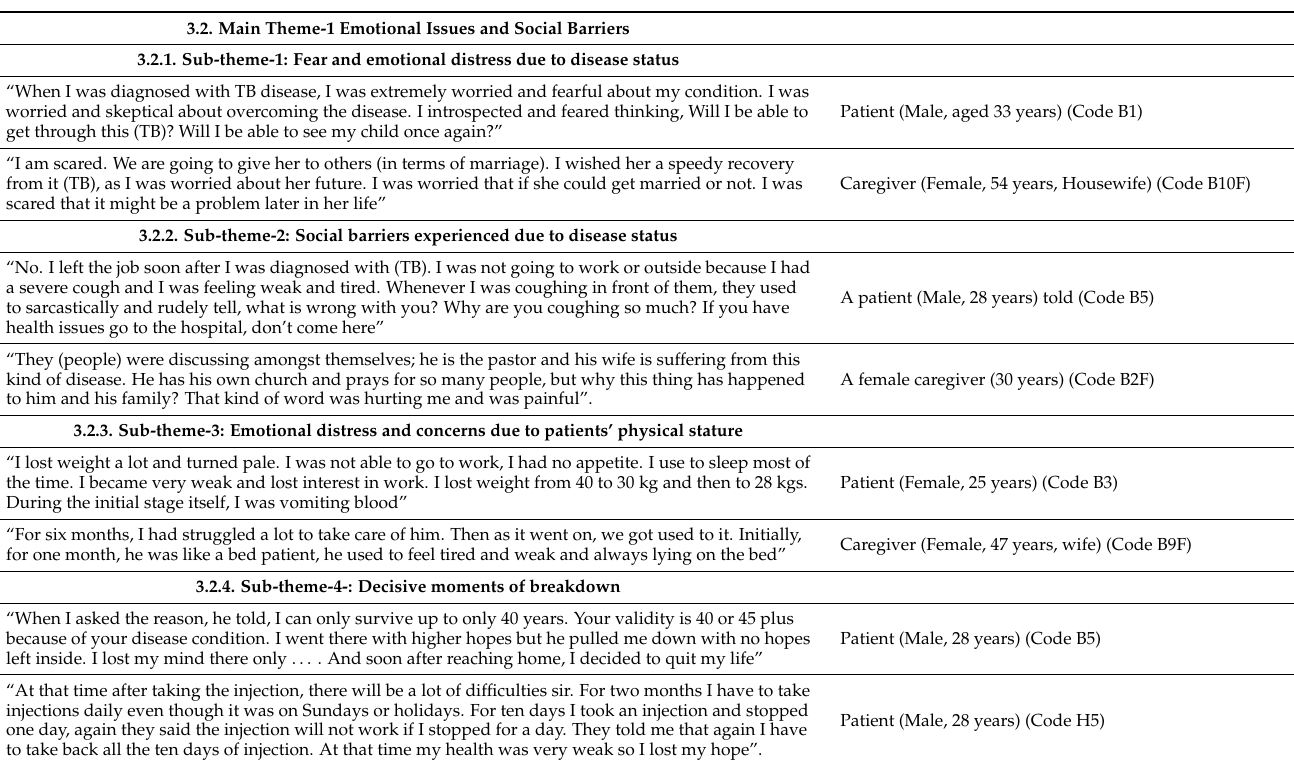
Table 2. Quotes reflective of the theme “Emotional issues and social barriers” and its